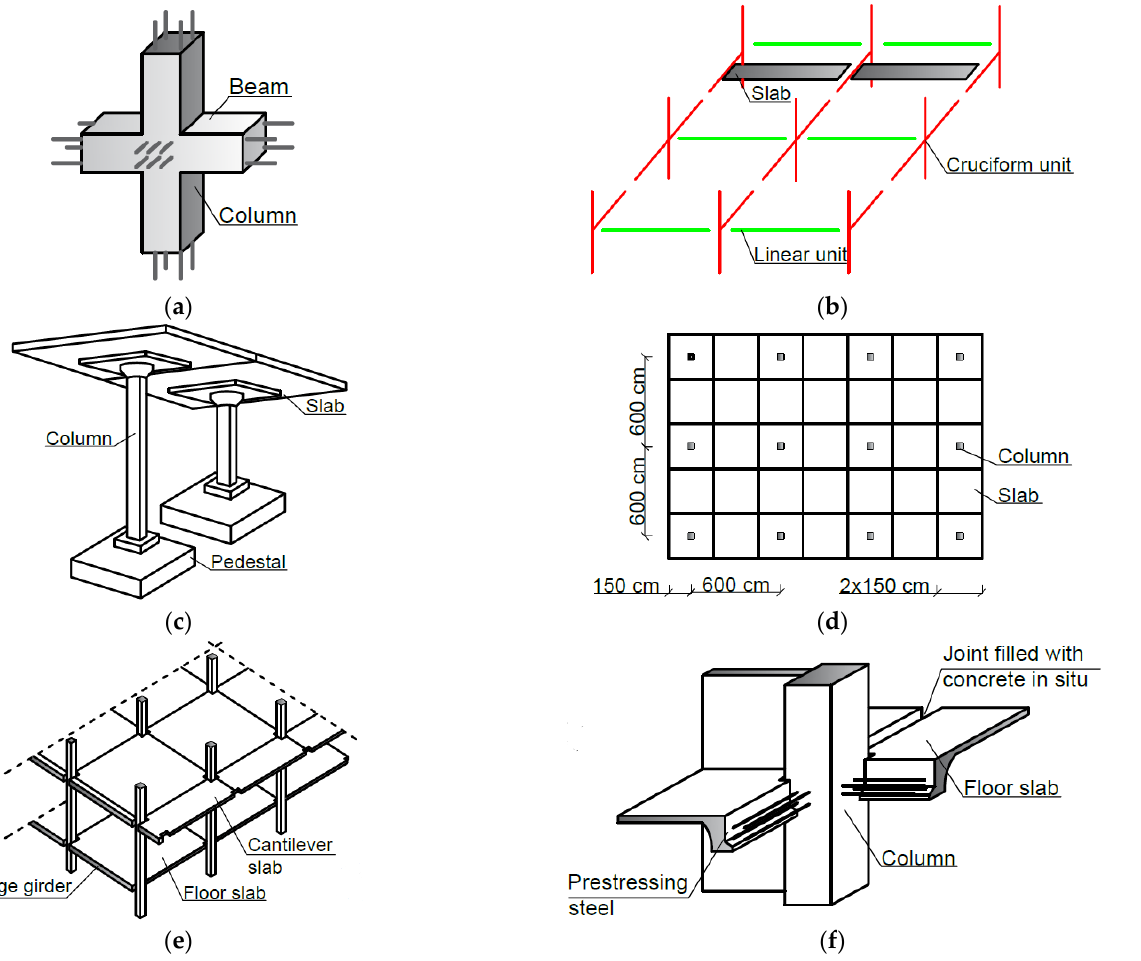
Figure 1. Four typical types of prefabricated constructions based of the load bearing structure (based on the information provided in [10,11]).